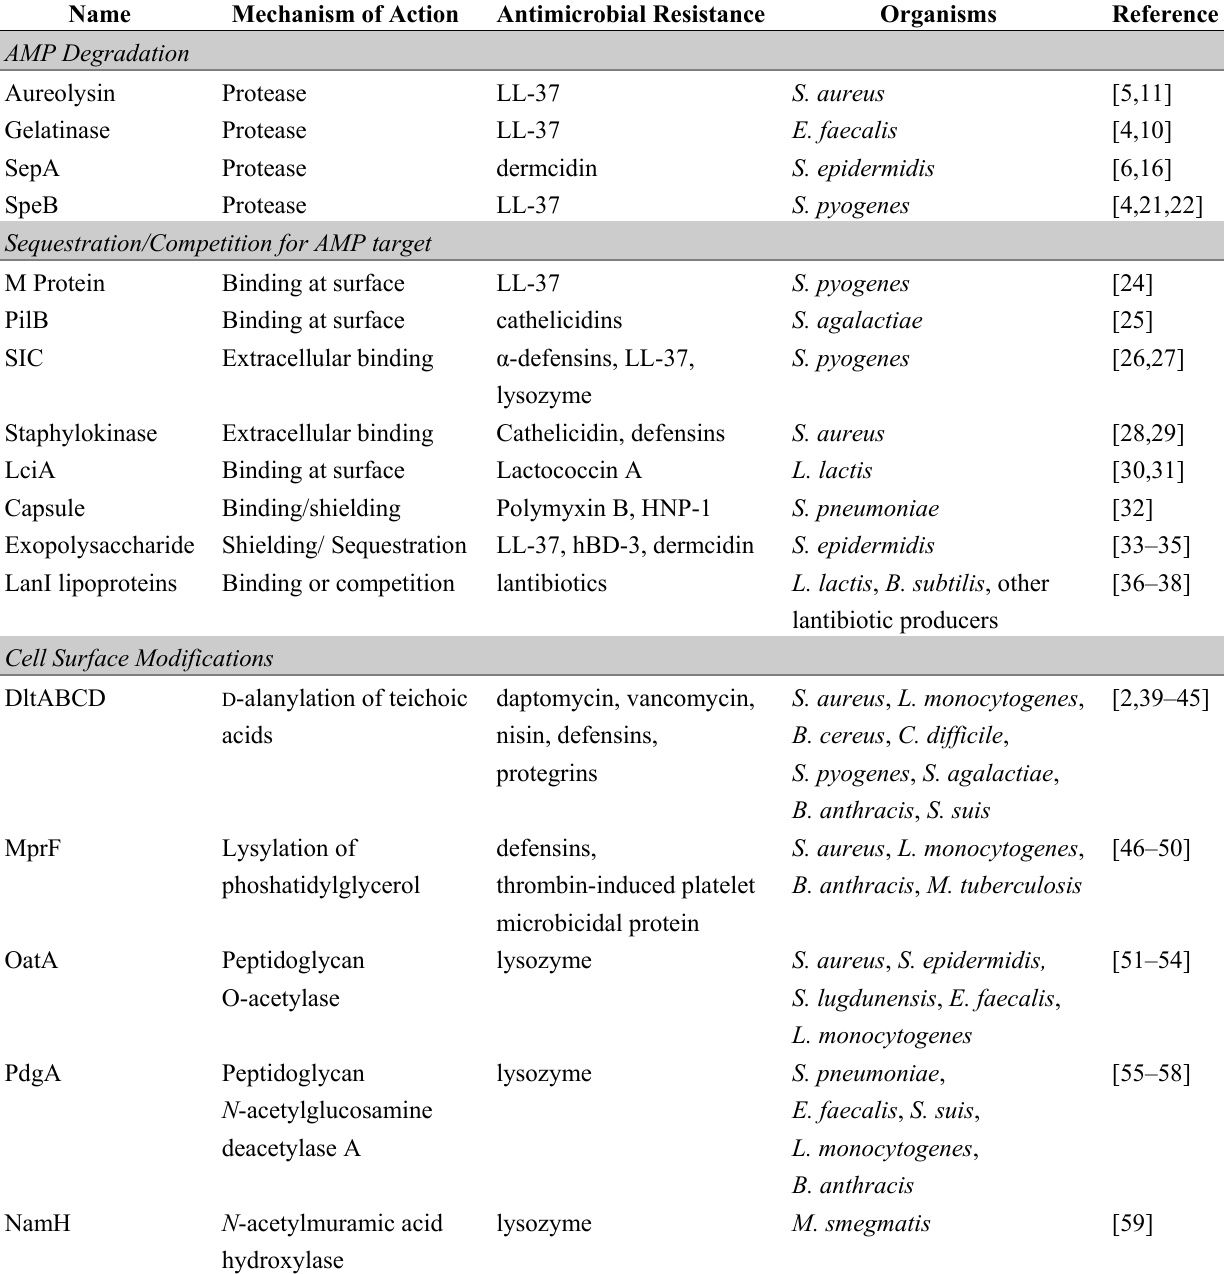
Table 1. Summary of Gram-positive Antimicrobial Peptides (AMP) Resistance